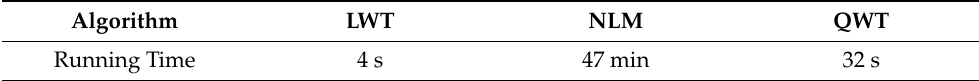
Table 1. Comparison of running time of denoising